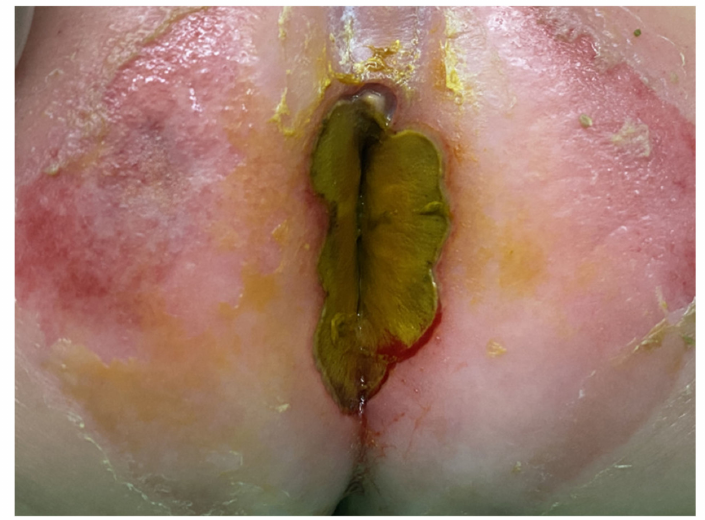
Figure 1. There was a gangrenous change on the skin near the anus. Teicoplanin, Meropenem, and Clindamycin were prescribed. However, despite ag- gressive treatment and resuscitation, consciousness change, poor activity, and progressive perineal necrotic change were still noted two days later. Hence, emergency surgery was performed for debridement and sigmoid colostomy. Pathology of perineal tissue revealed extensive necrosis, fibrinous deposition, and bacterial colonies. Wound culture revealed Pseudomonas aeruginosa infection. Antibiotics were changed to ceftazidime and gentamicin. Subsequently, his leukopenia and high C-reactive protein improved gradually. The wound was packed with wet gauze three times a day initially and changed to Ag-aquacel daily later. As his condition stabilized, he was discharged 15 days after the operation. After discharge, the wound around the anus was continuously packed with Ag- aquacel, and anal dilator #10 was used daily to keep the orifice of the anus patent. Another wound debridement was performed two months later due to a polypoid granulation tissue in the wound (Figure